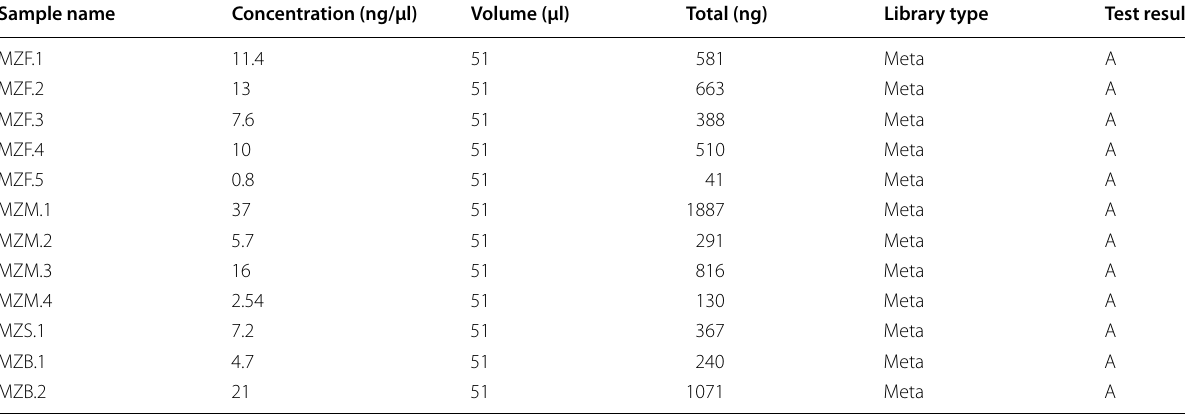
Table 2 The detection report of